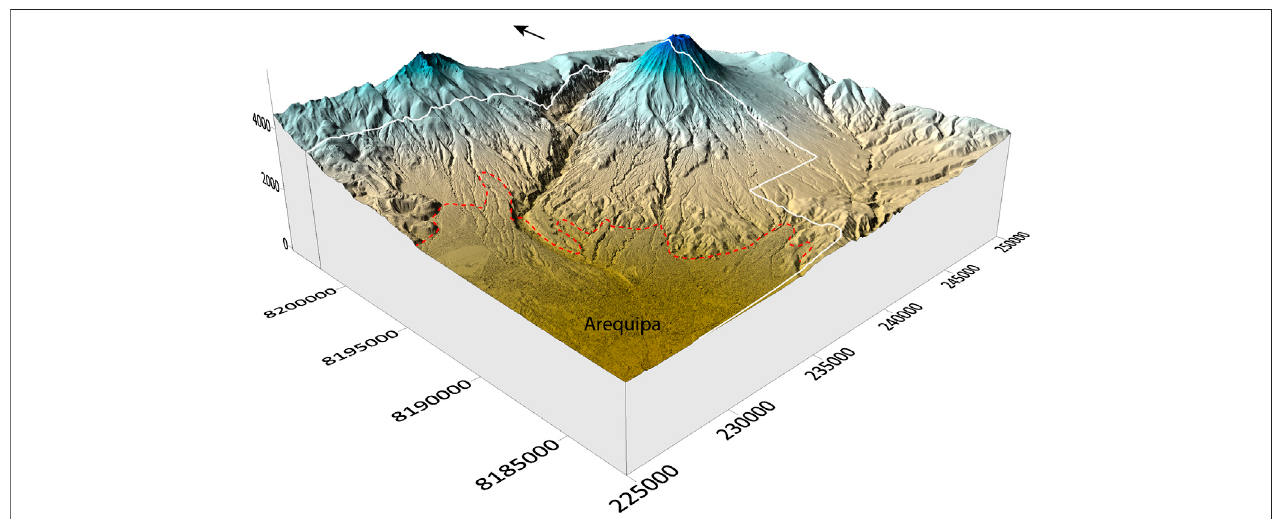
FIGURE 3 | 3-D view of the 2 m fused digital surface model oriented from Arequipa to the NE. The white outline de fi nes the boundary between the coverage of the 2 mPleiadesdigitalsurfacemodel(onthewest)and the10 mTanDEM-X DEM (ontheeast).Thereddashed outlinede fi nestheboundaryoftheurban areaofArequipa. The black arrow indicates the North direction. Coordinates are in UTM